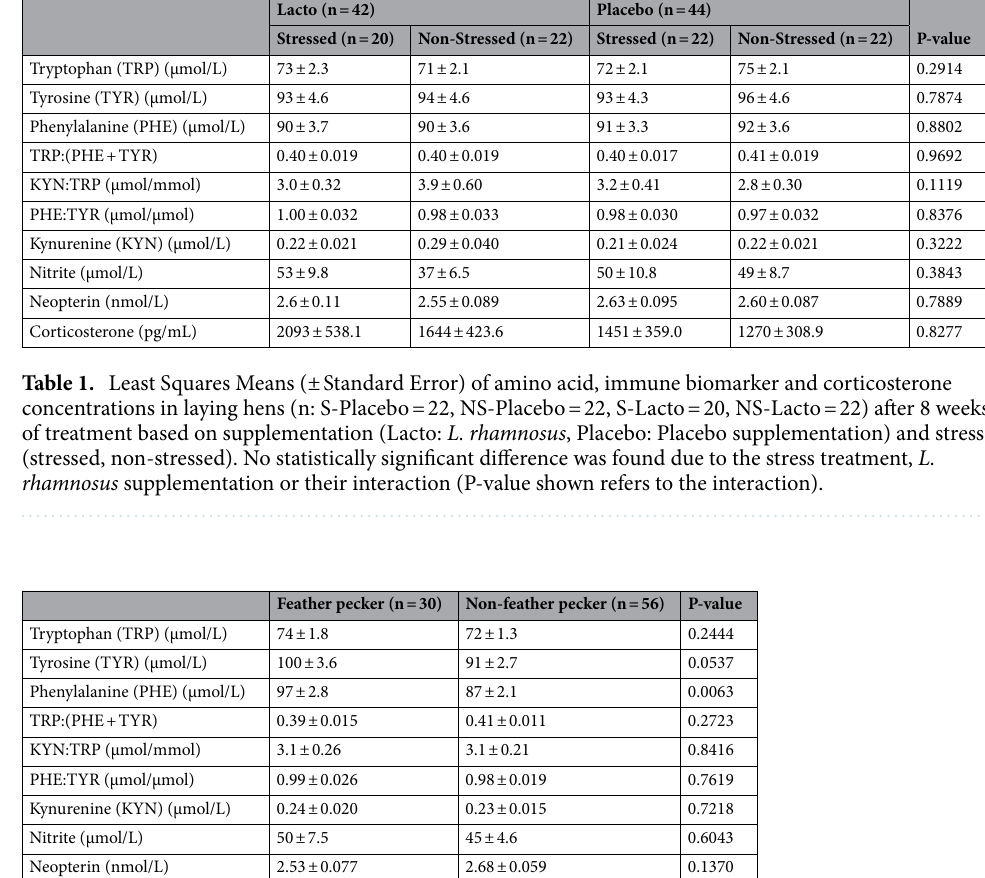
Table 2. Least squares means (± Standard Error) of the amino acid, immune biomarker and corticosterone concentrations in laying hens according to their feather pecking phenotype. A feather pecker was characterized as a bird that displayed severe feather-pecking behavior at least once between 24–26 weeks of age.